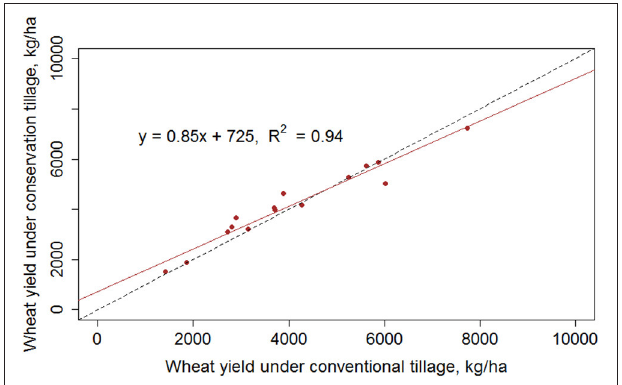
FIGURE 4 | Relative winter wheat yields in the inland PNW under conventional tillage (x-axis) and conservation tillage (y-axis).